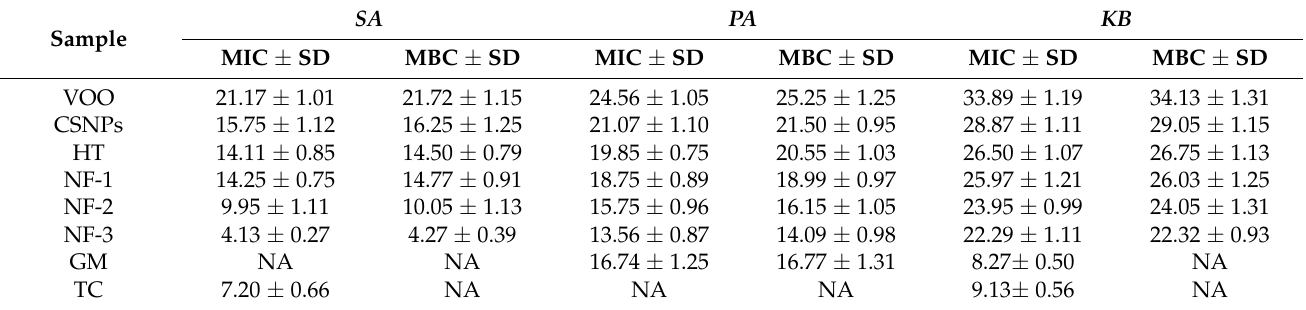
Table 3. MIC and MBC values ( µ g/mL) of new PBA-CSNPs-supported NFs against ESKAPE pathogens, as compared to clinical antibiotics (GM and